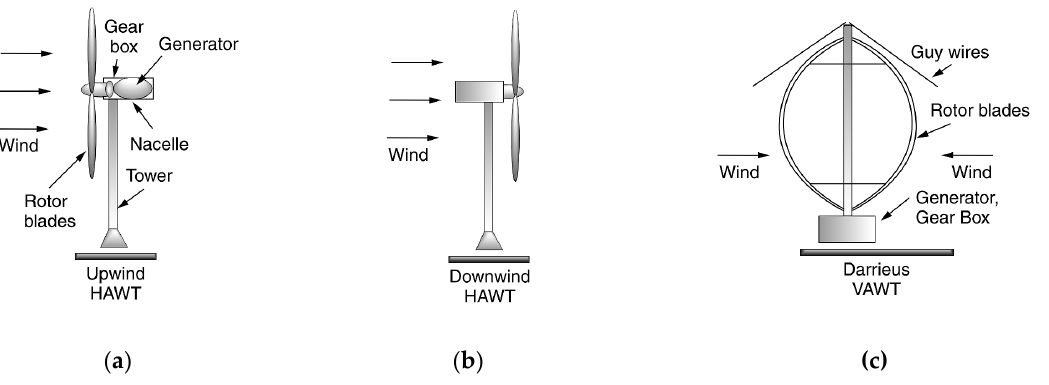
Figure 2. Horizontal axis wind turbines (HAWT): ( a ) upwind HAWT, and ( b ) downwind HAWT. Vertical axis wind turbine (VAWT): ( c ) Darrieus VAWT.